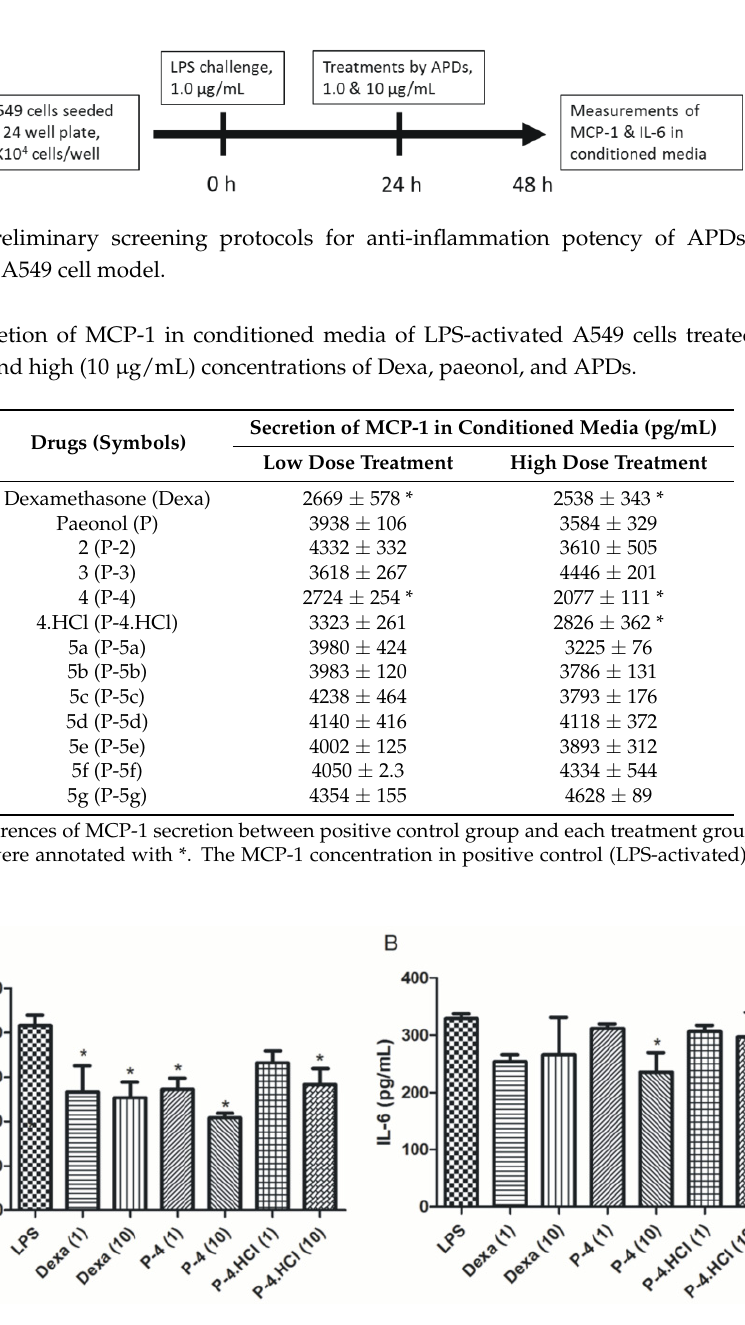
Figure 2. Secretion of ( A ) MCP-1 and ( B ) IL-6 in conditioned media of LPS-activated A549 cells treated with Dexa (1.0 µg/mL and 10 µg/mL) and selected APDs (1.0 µg/mL and 10 µg/mL). Significant differences between each treatment group and LPS-activated (positive control) group at p values less than 0.05 were annotated with *.